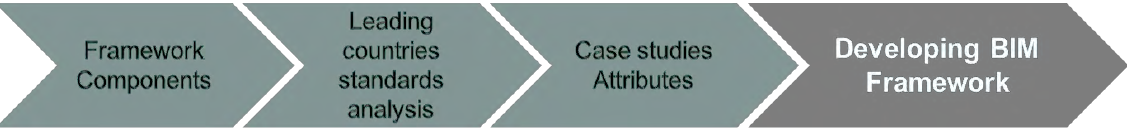
Figure 11. generationprocess of the